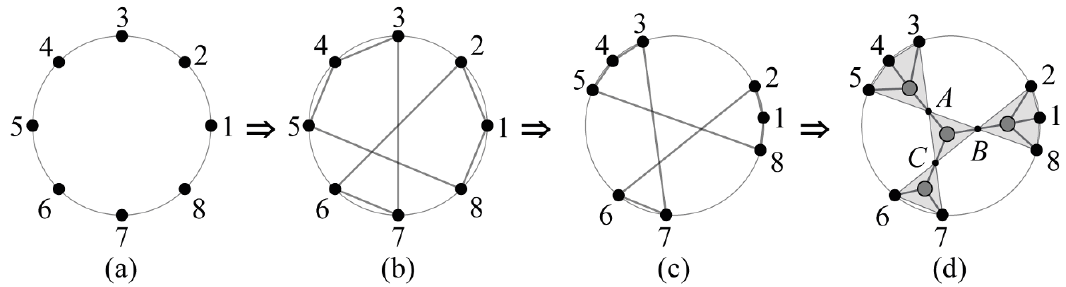
Figure 1 . The procedure to obtain the e(cid:11)ective Feynman diagram for the ordering (cid:25) = (12345678) and (cid:26) =